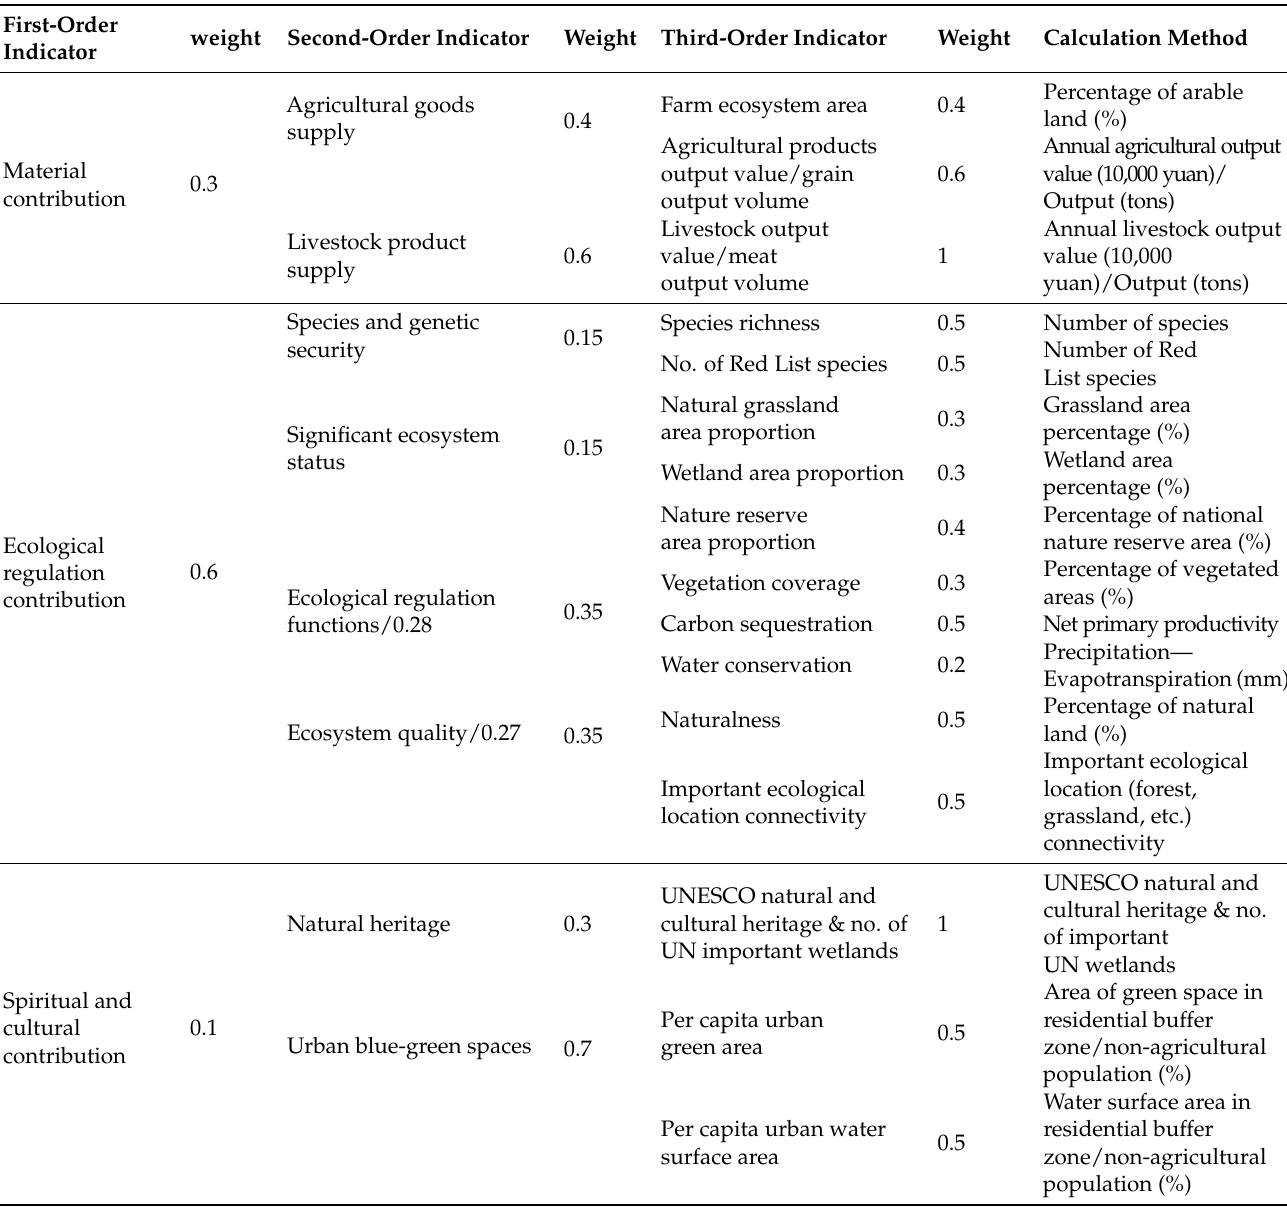
Table A3. Expert